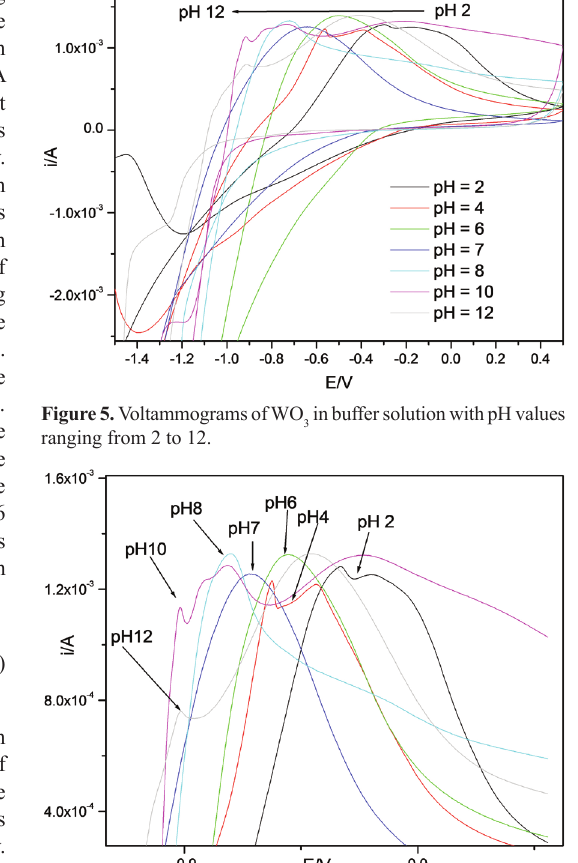
in buffer solution with pH 3